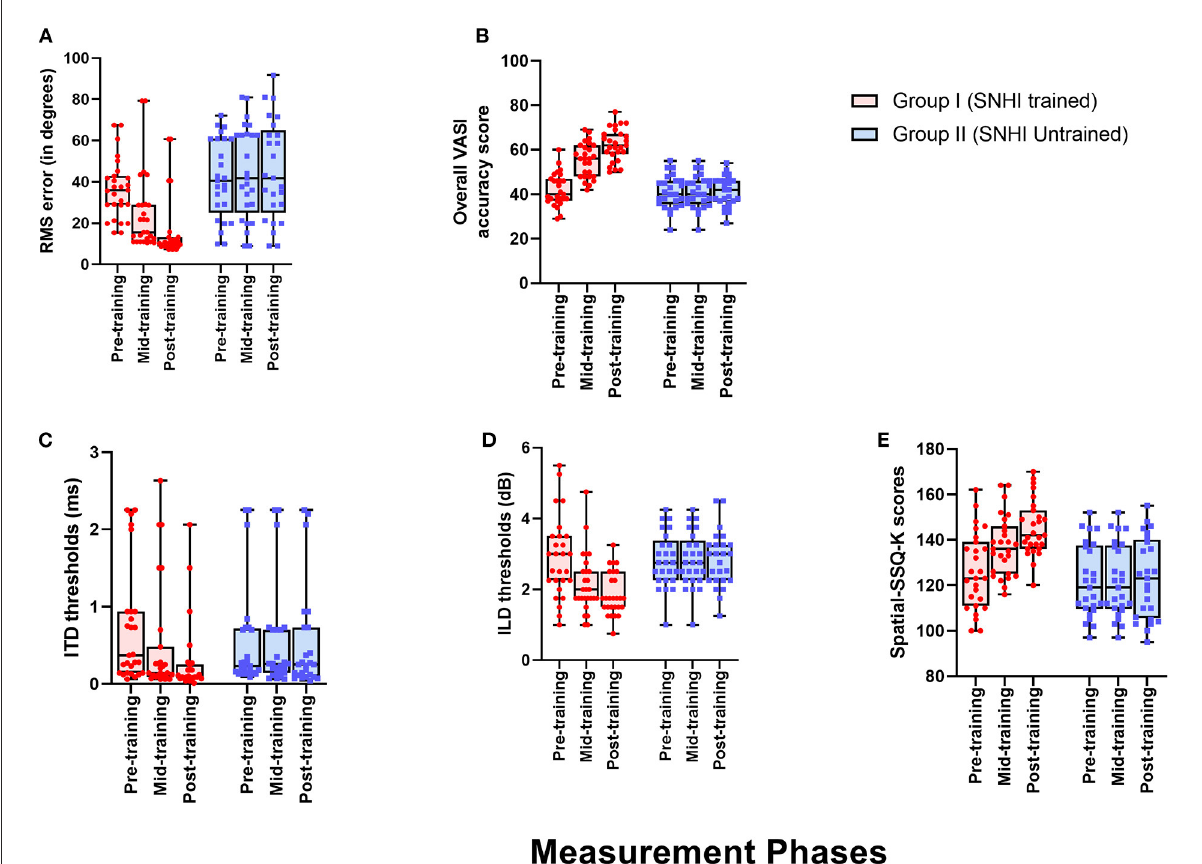
FIGURE5 Comparison of spatial acuity of group I (SNHI-trained) and group II (SNHI-untrained) participants as a function of VAST in (A) test of spatial acuity in free field, (B) test of spatial acuity in closed-field, (C) interaural time difference thresholds, (D) interaural level difference thresholds, and (E) subjective ratings. The horizontal line in each box plot at center represents the median, while the “ + ” sign indicates the mean for each test. The box area corresponds to interquartile range, while the error bar indicates interquartile deviation. The Bonferroni comparisons between pre-, mid-, and post-evaluations were given for only group I participants, as similar comparisons for group II yielded no difference between evaluations.